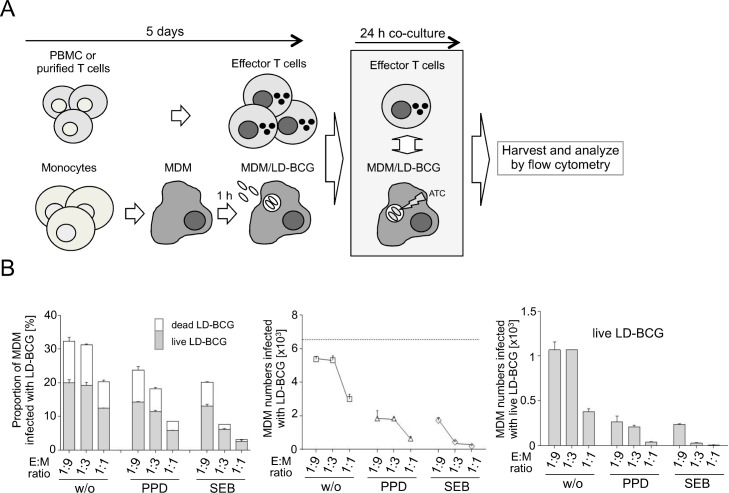
In vitro generation of effector T cells (E) and co-culture with LD-BCG infected MDM (M) at different E/M ratios.(A) Workflow depiction for the generation of effector T cells, LD-BCG infected MDM, E/M co-culture, flow cytometry analyses of infected MDM and effector T cells. (B) Analyses of MDM infected with LD-BCG after co-culture with effector T cells stimulated with Staphylococcus Enterotoxin B (SEB), M. tuberculosis Purified Protein Derivative (PPD), and without stimulation (w/o). Different E/M ratios are shown on the x-axes. Proportions of infected MDM with live (grey) or dead LD-BCG (open) are shown as stacked boxes (left graph). Absolute numbers of infected MDM are shown as symbols (middle graph) and numbers of MDM infected with live LD-BCG are shown as boxes (right graph). The dotted line in the middle graph indicates MDM numbers infected with LD-BCG w/o effector T-cell co-culture. Median with range of triplicates from a representative experiment are depicted.